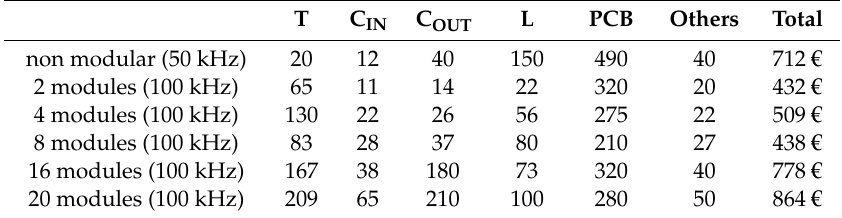
Table 3. System costs evaluation for various bi-BB concept dependent on Nr. of modules.